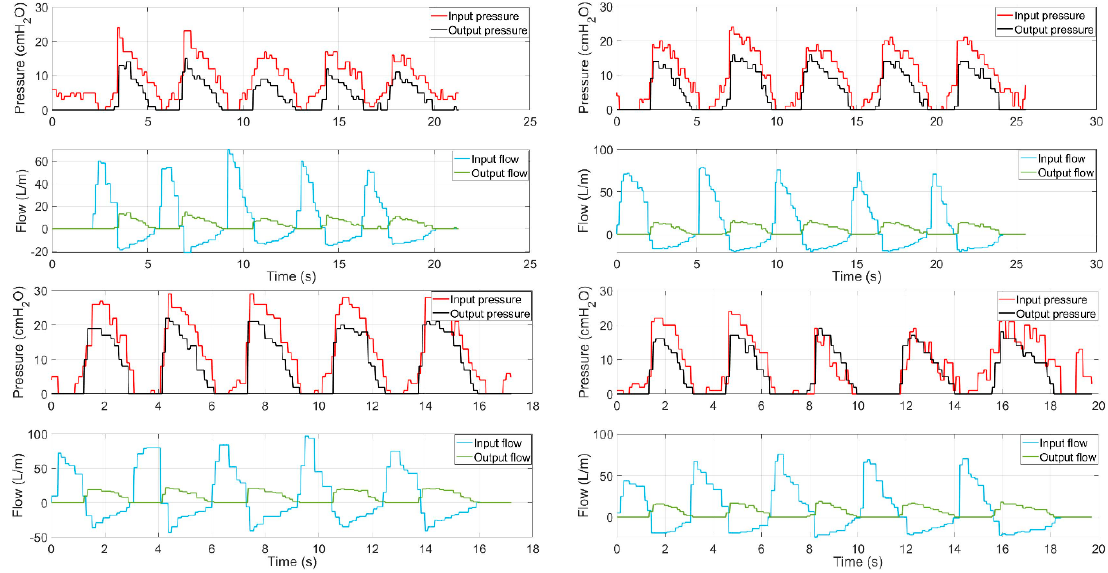
Figure 24. Experimental results of assisted breathing mode (ABM)